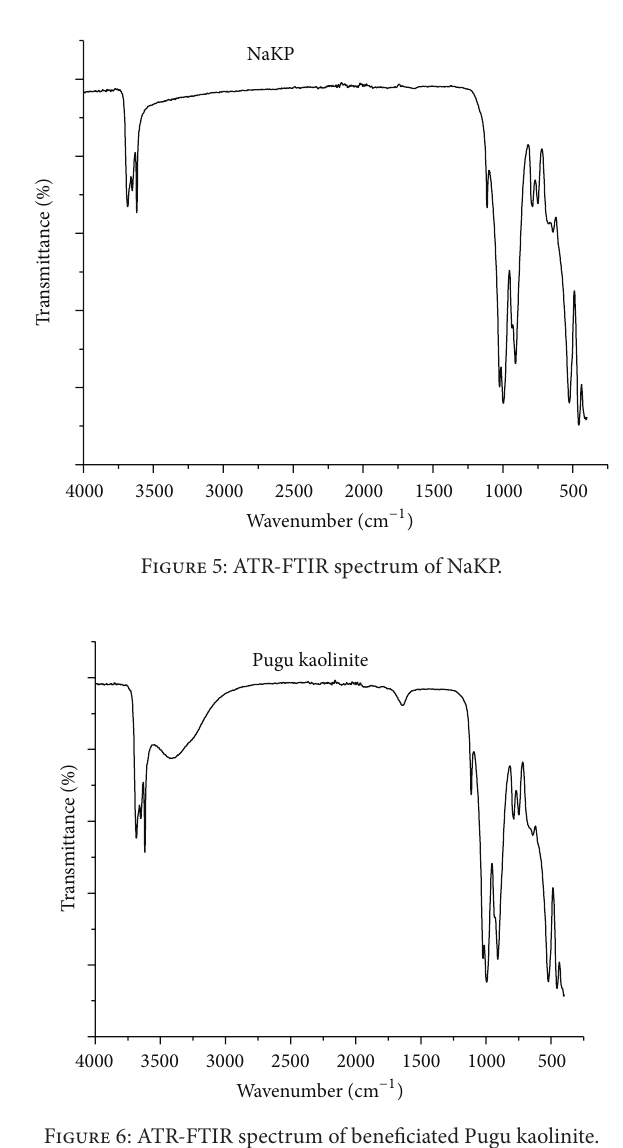
Figure 6: ATR-FTIR spectrum of beneficiated Pugu